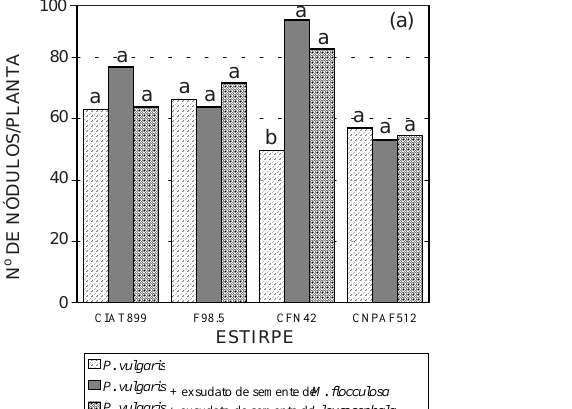
P. vulgaris P. Figura 5. Número de nódulos de feijoeiro, cv. Carioca, crescido em condições axênicas (a) e solo (b), com diferentes estirpes de Rhizobium inoculadas, suprido ou não com exsudatos de sementes de M. flocculosa ou L. leucocephala e, ou, N-mineral. Valores médios de quatro repetições. Letras diferentes dentro dos tratamentos de cada estirpe de rizóbio diferem pelo teste de Tukey (P < 0,05).